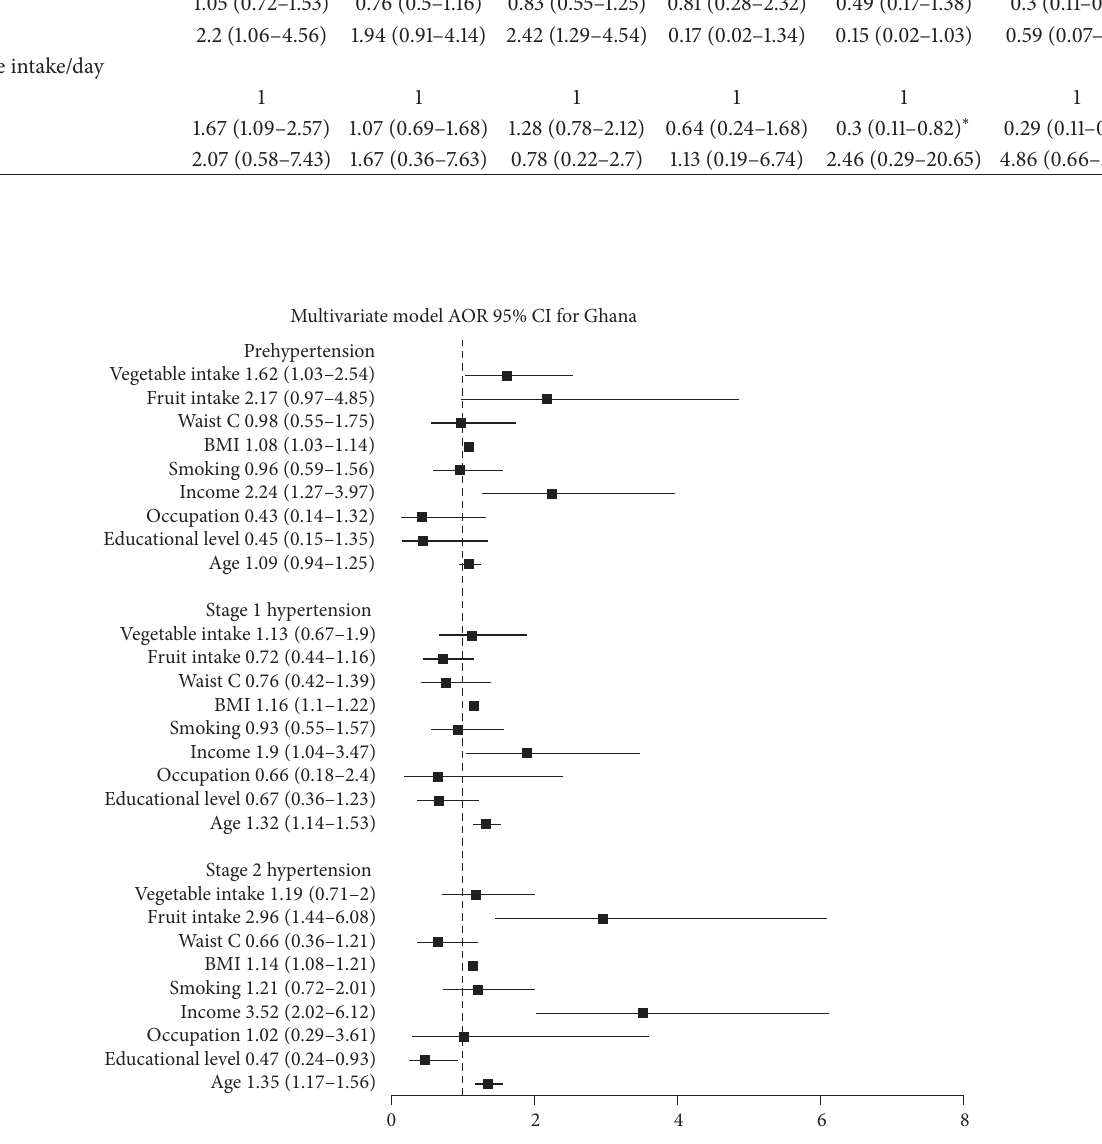
Figure 1: Adjusted odds ratios and 95% confidence intervals for stages of hypertension,